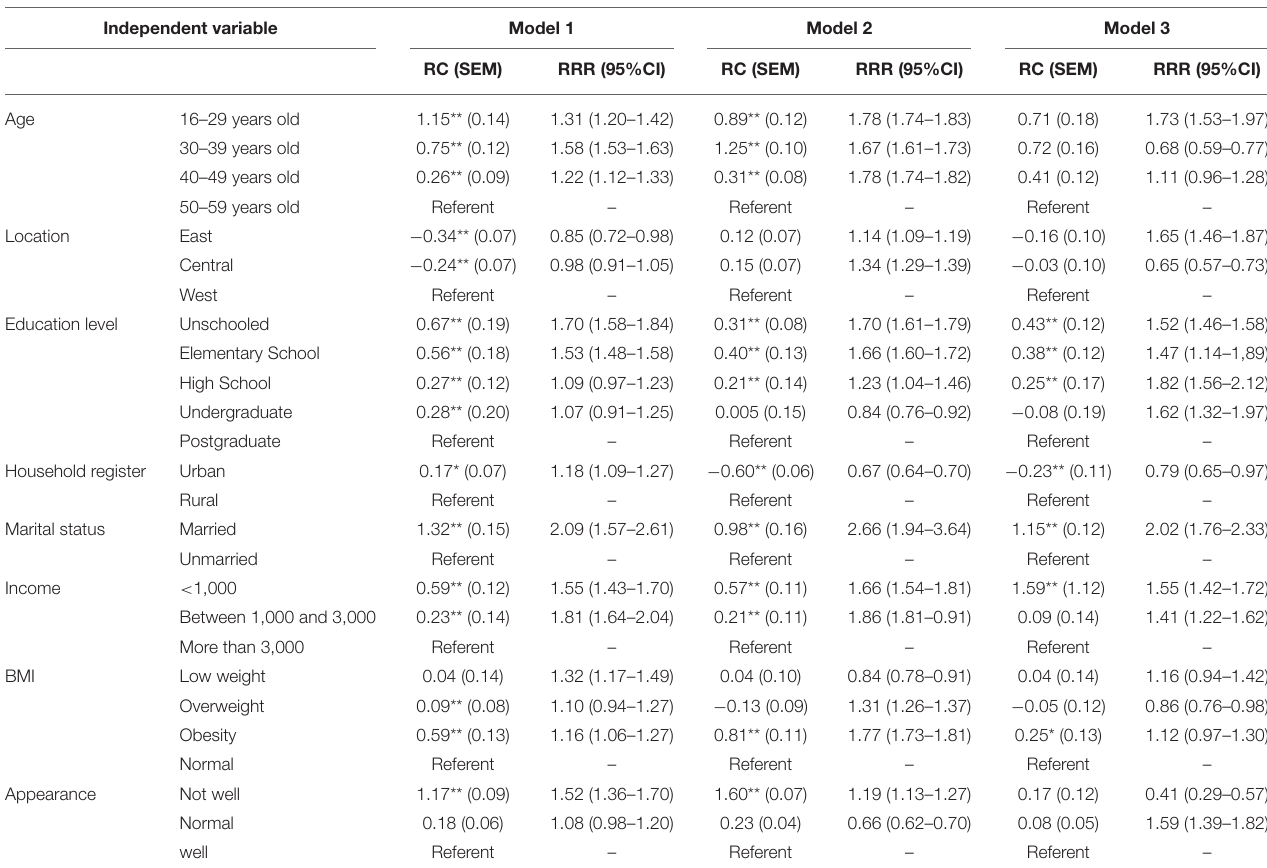
TABLE 2 | Multiple Logistic Regression models of contributing factors of female participation in physical activity (personal